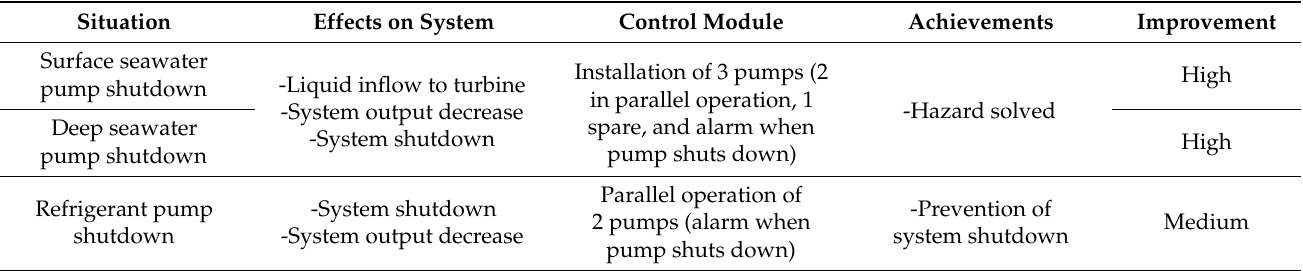
Table 5. Performance results of improved